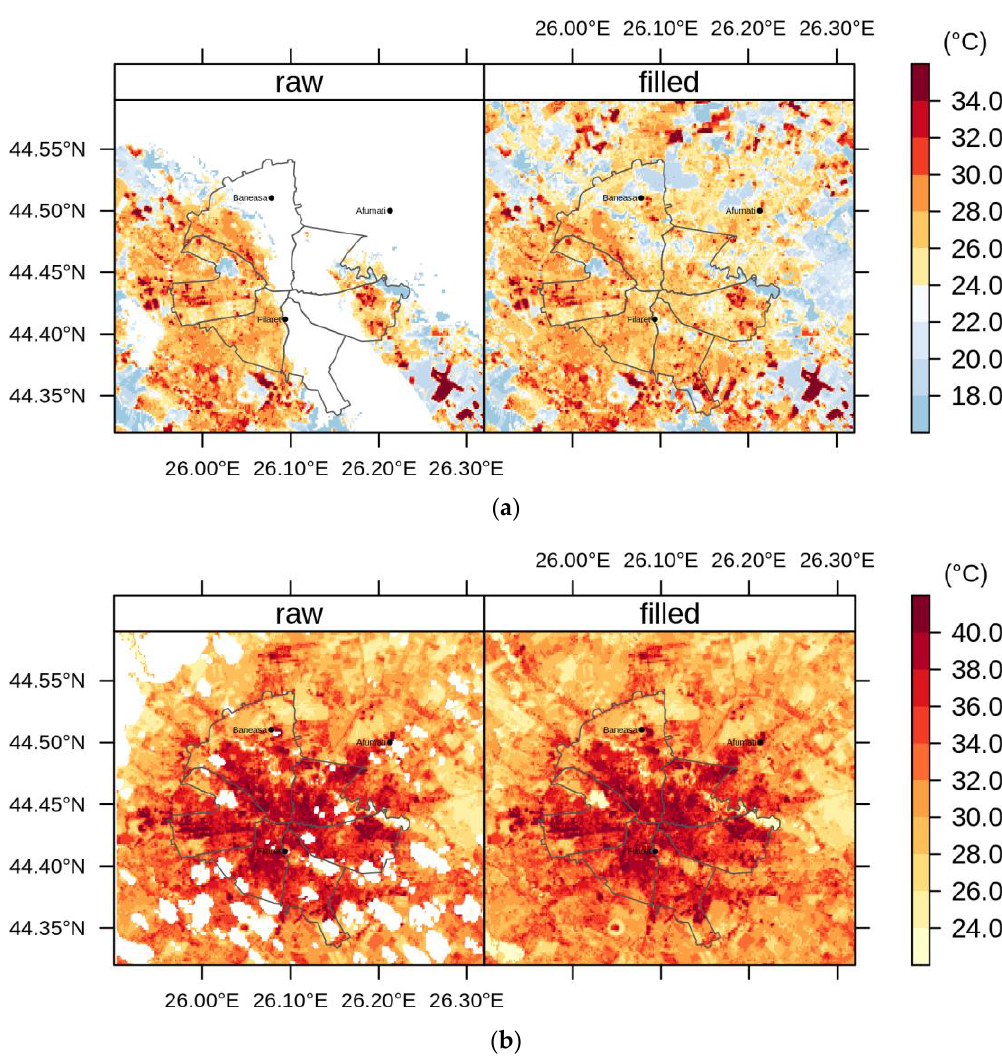
Figure 3. Land surface temperature (LST) (°C) over Bucharest (Romania) as retrieved from raw and gap-filled Landsat 8 images for 23 April 2013 ( a ) and 25 June 2016 ( b ). White spots correspond to missing data.